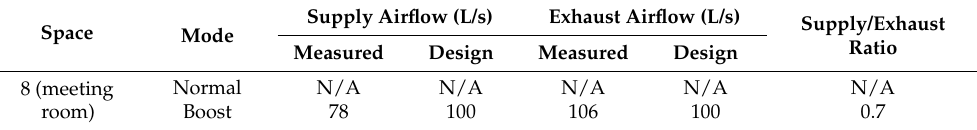
Table 10. Measured and designed airflows for Type 4 space (both all-air and air–water systems with normal and boost